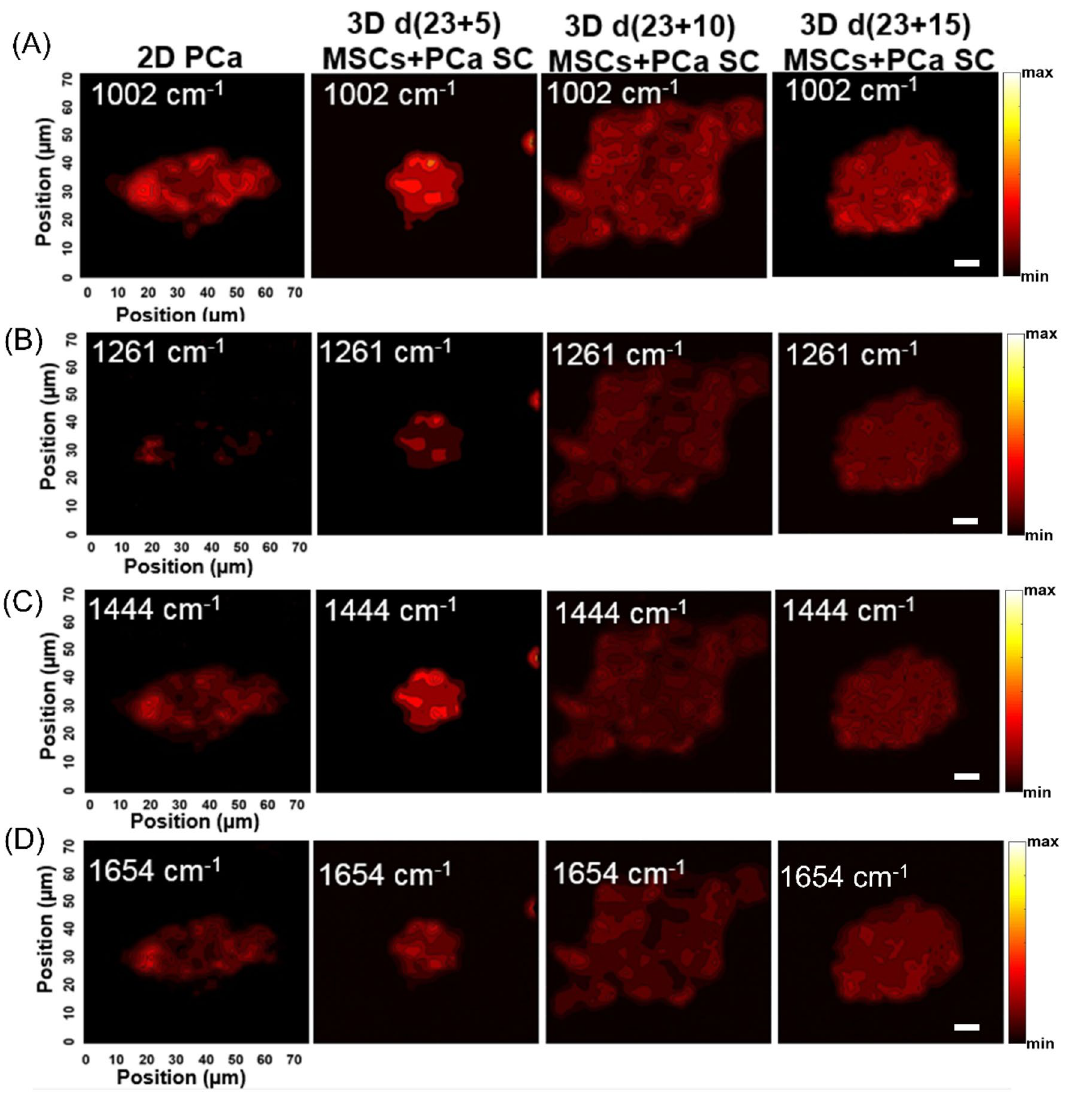
Figure 4. Raman maps of prostate cancer cells. Raman mapping images obtained from 2D PCa and three 3D MSCs + PCa SCs for vibrational signatures of: ( A ) 1002 cm −1 , ( B ) 1261 cm −1 , ( C ) 1444 cm −1 , and ( D ) 1654 cm −1 . Scale bars, 10 µm ( A – D